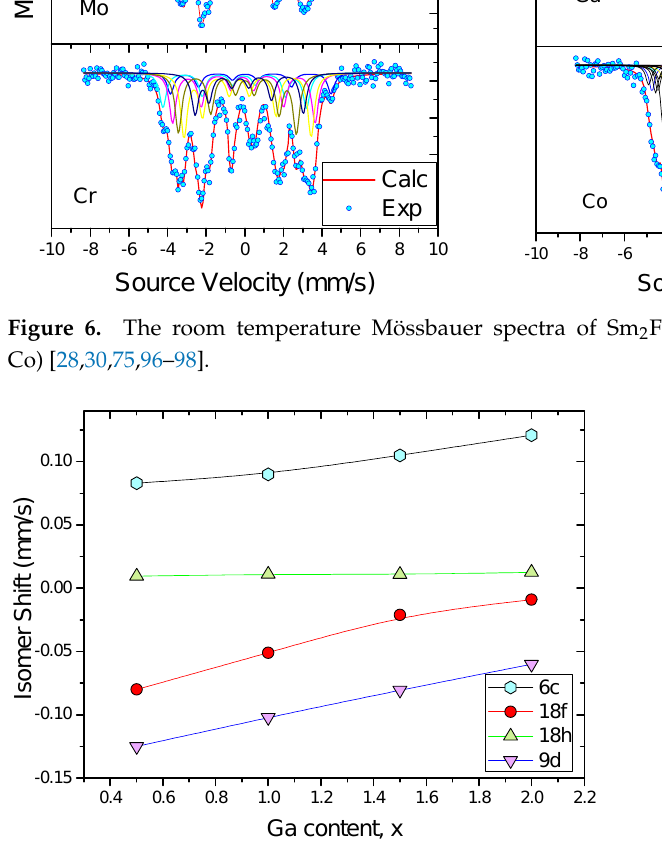
Figure 7. Isomer shift evolution vs substituted Ga atom composition for Sm 2 Fe 17 − x Ga x